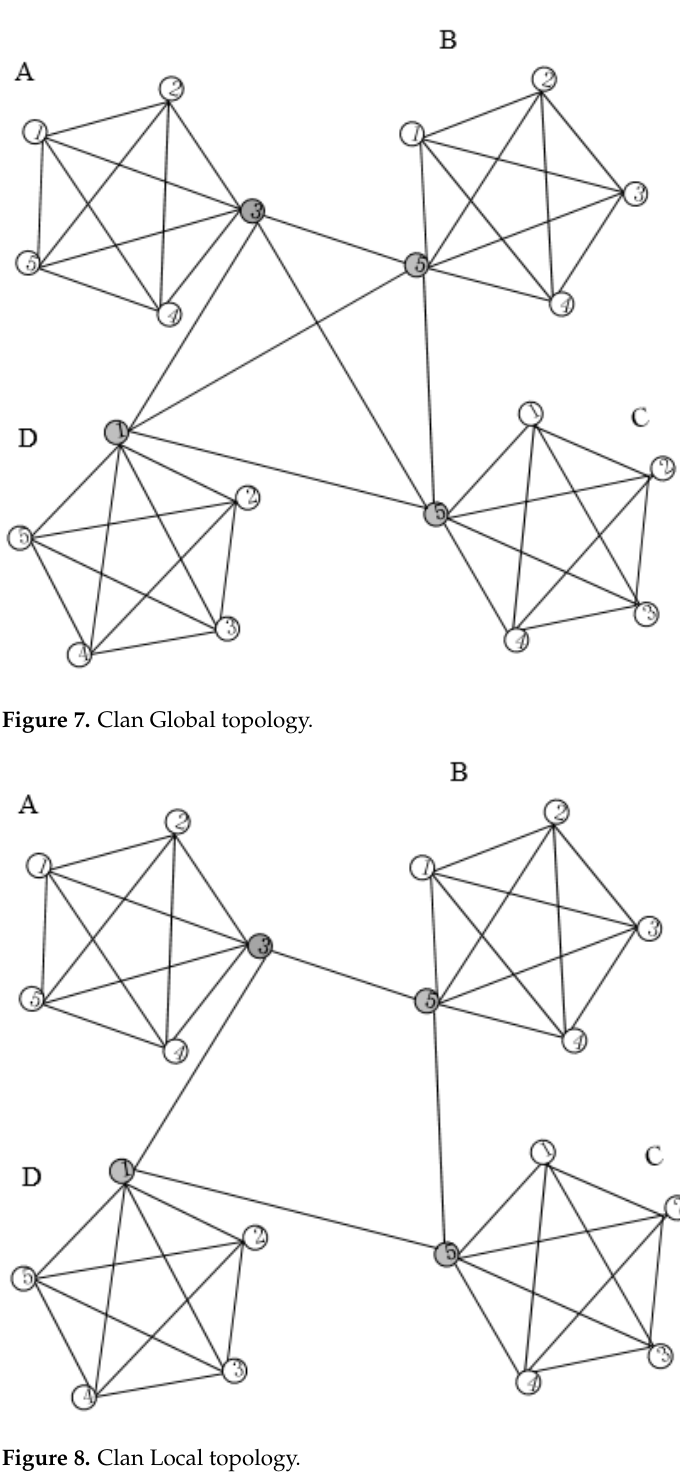
Figure 8. Clan Local